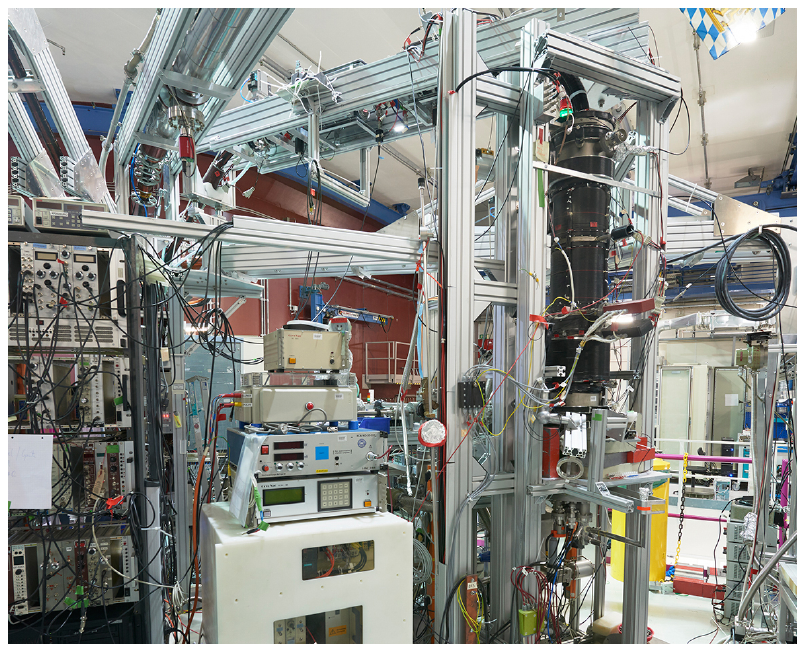
Figure 1: Instrument PLEPS at NEPOMUC (Copyright by W. Schürmann,